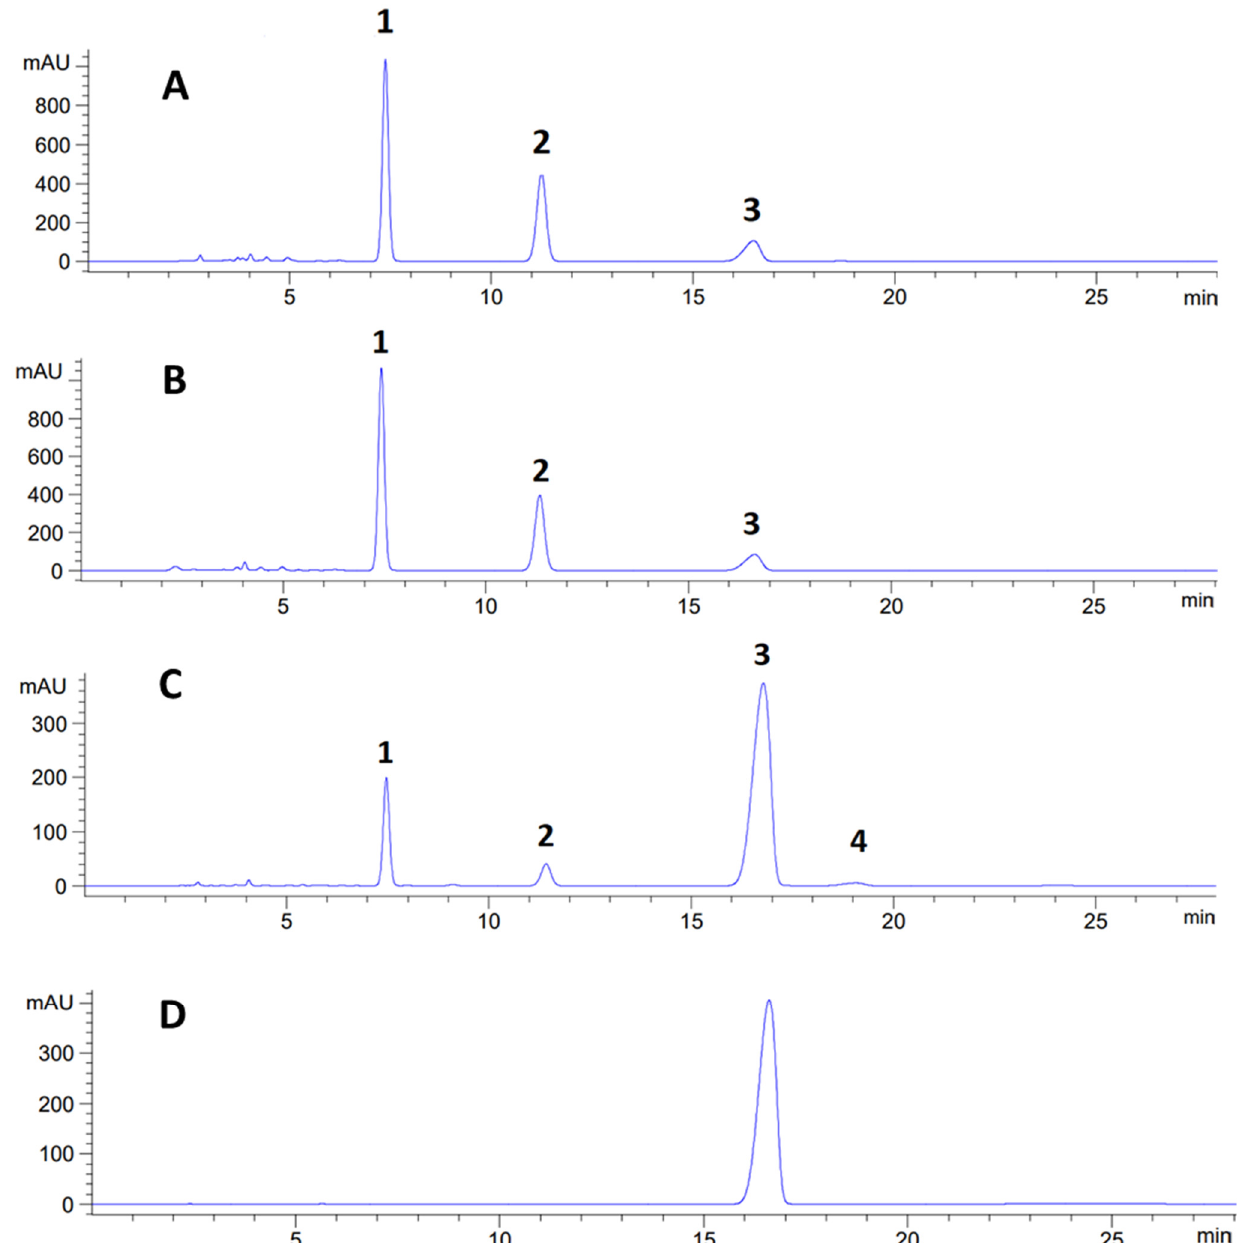
Figure 1. HPLC chromatograms of acetonic, methanolic, and hexanic extracts of lichen Xanthoparmelia stenophylla and the isolated compound usnic acid obtained at 254 nm. 1 — Lecanoric acid; 2 — obtusic acid; 3 — usnic acid; 4 — atranorin. ( A ) Chromatogram of Xanthoparmelia stenophylla acetonic extract obtained at 254 nm; ( B ) chromatogram of Xanthoparmelia stenophylla methanolic extract obtained at 254 nm; ( C ) chromatogram of Xanthoparmelia stenophylla hexanic extract obtained at 254 nm; ( D ) chromatogram of usnic acid obtained at 254 nm.